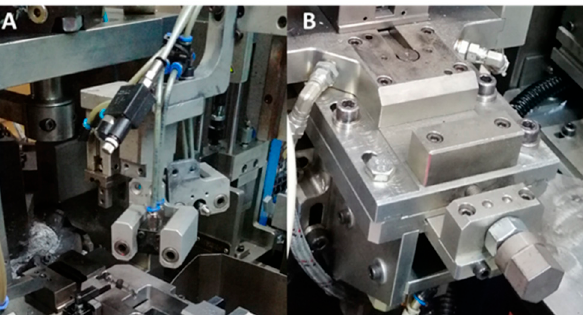
Figure 20. Equipment after disassembling the components to be changed: ( A ) robotic manipulator grips, ( B ) measuring kit.